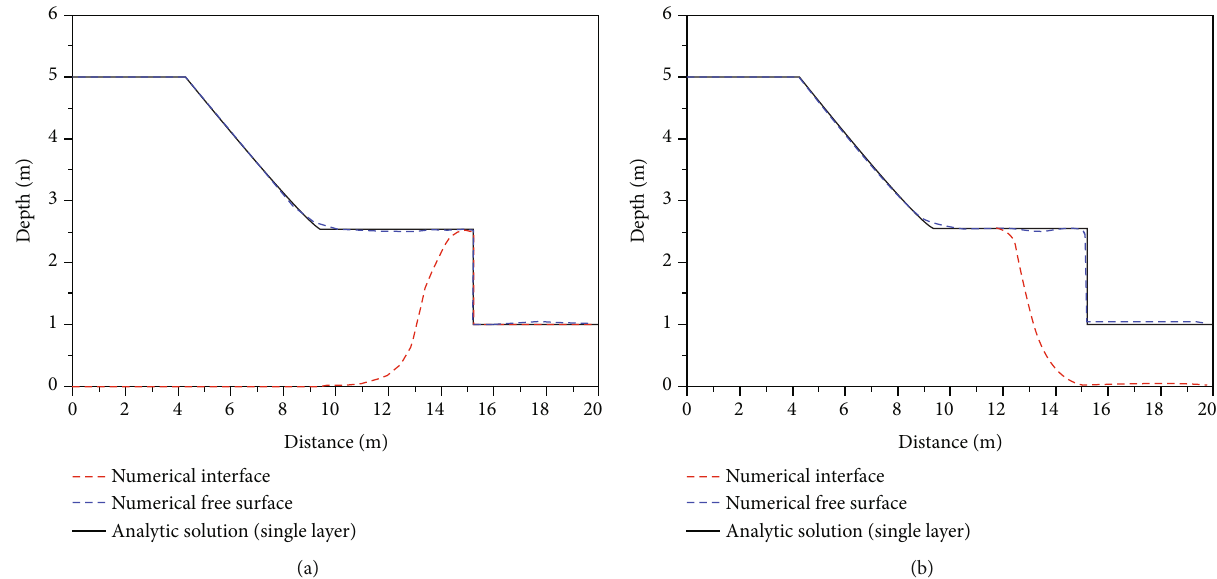
Figure 3: Numerical results of the dam-break fl ow at 0.8s. (a) Case1. (b) Case2.